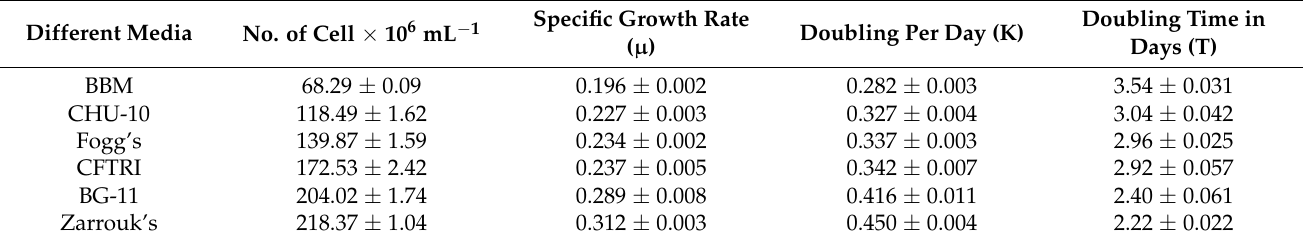
Table 2. Evaluation of growth kinetics of Scenedesmus rotundus -MG910488 grown in the different growth